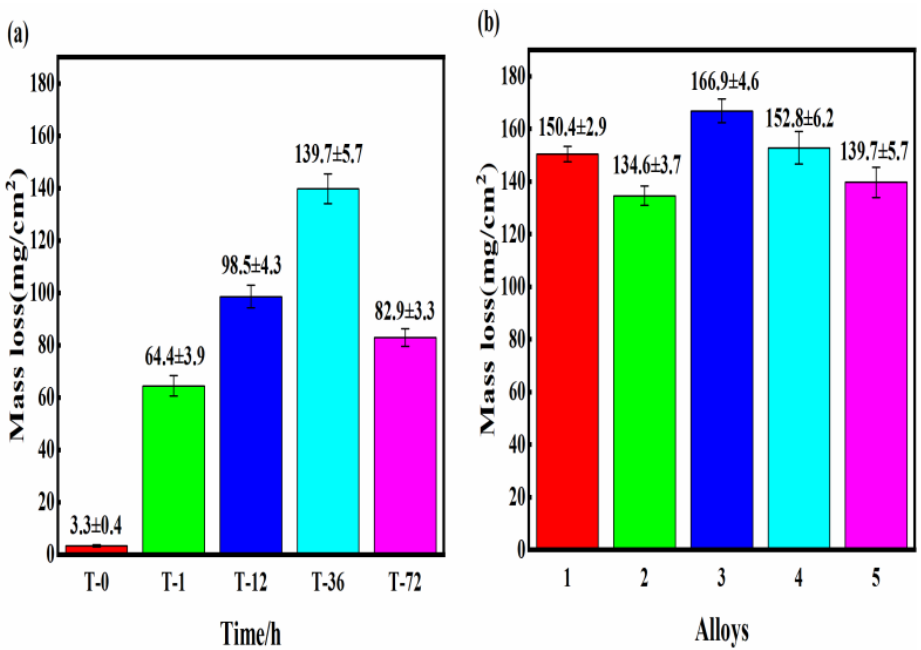
Figure 10. Mass loss after NAMLT ( a )the alloy 5 after aging at 180 ◦ C for different aging times, ( b ) all of the tested five alloys during peak aging at 180 ◦ C (alloy 1: Al-4.5Mg-0.6Zn-0.2Cu; alloy 2: Al- 4.5Mg-0.6Zn-0.5Cu; alloy 3: Al-4.5Mg-0.6Zn-0.5Cu-0.2Ag; alloy 4: Al-4.5Mg-0.6Zn-0.5Cu-0.4Ag; alloy 5: Al-4.5Mg-0.6Zn-0.5Cu-0.7Ag) [33].